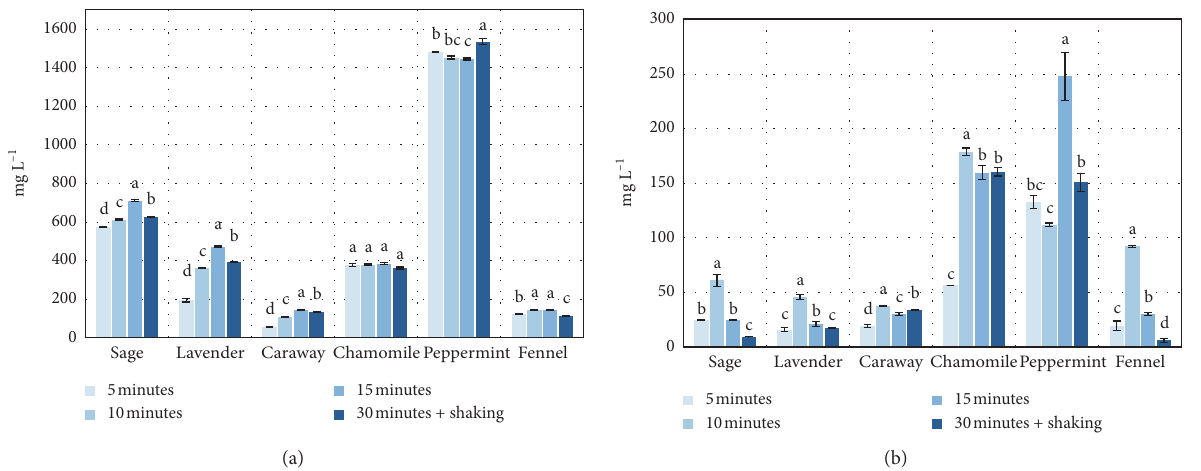
Figure 5: Concentration of polyphenols expressed in gallic acid equivalents (a) and flavonoids expressed in quercetin equivalents (b) in secondary herbal brews (after primary brewing) (mg L − 1 ). Data are shown as mean ± SD. Different letters (a, b, c, etc.) show a significant difference with p < 0 . 05.